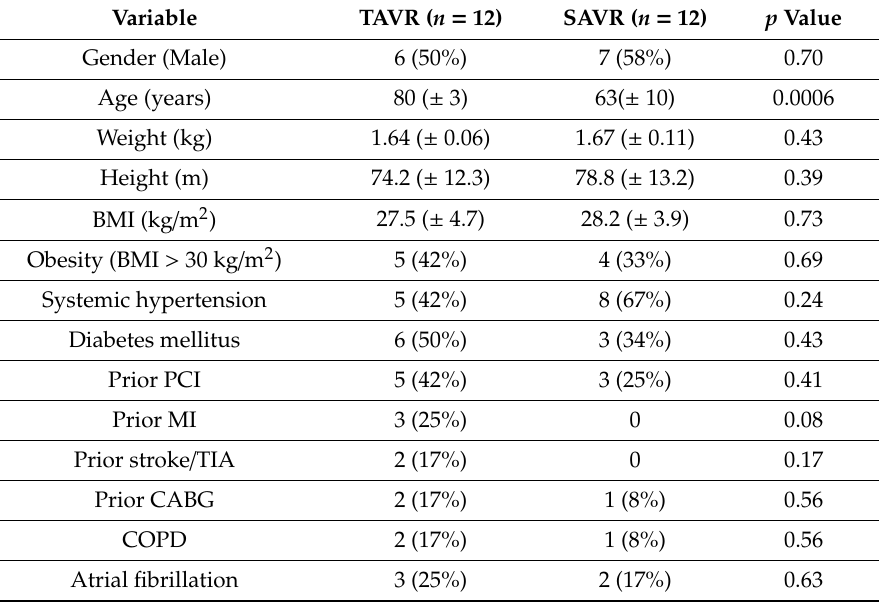
Table 1. Baseline characteristics of studied patients ( n = 24).